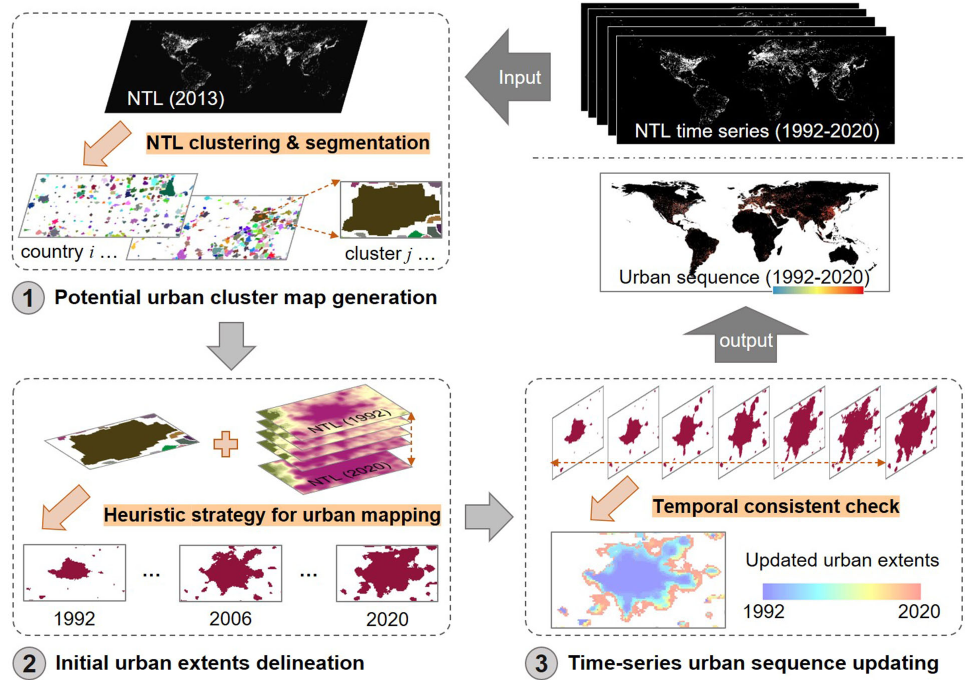
Figure 1. Framework of mapping global urban extents using NTL time-series observations.